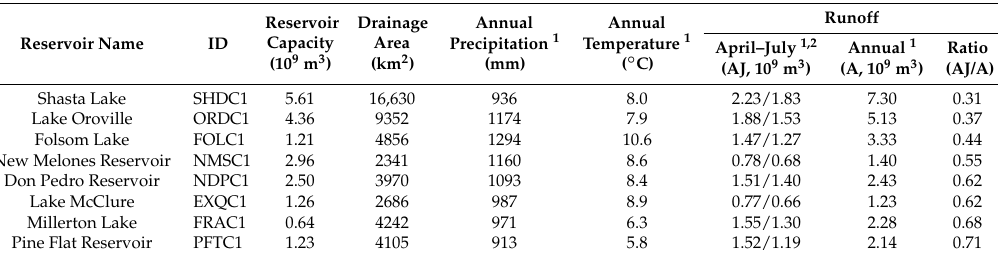
Table 1. Characteristics of study areas.